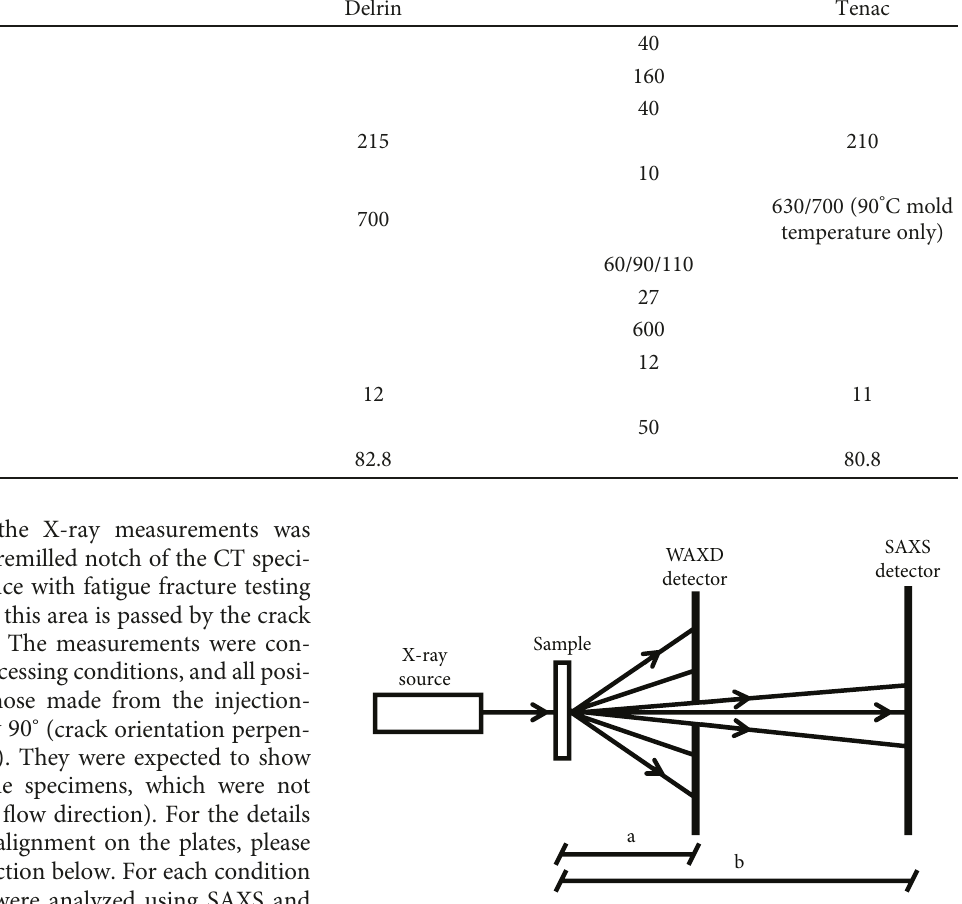
Figure 1: Setup for simultaneous SAXS and WAXD measurements (a was 49.9mm for all measurements, b was 1142.5mm for the plate scanning and 1097 mm for the CT specimen